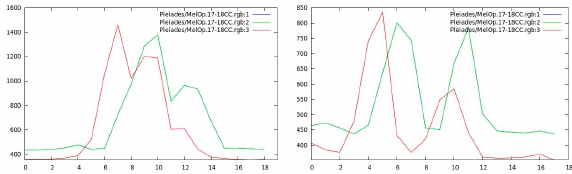
Figure 7: Displacement of cars seen by RapidEye (in cyan/red, section 900 × 280 m)